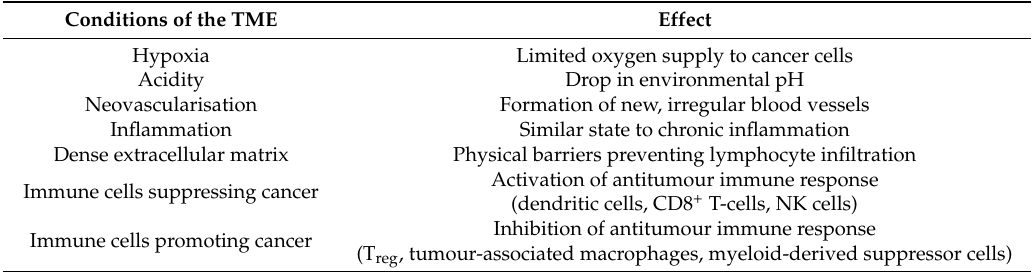
Table 1. Key conditions of the tumour